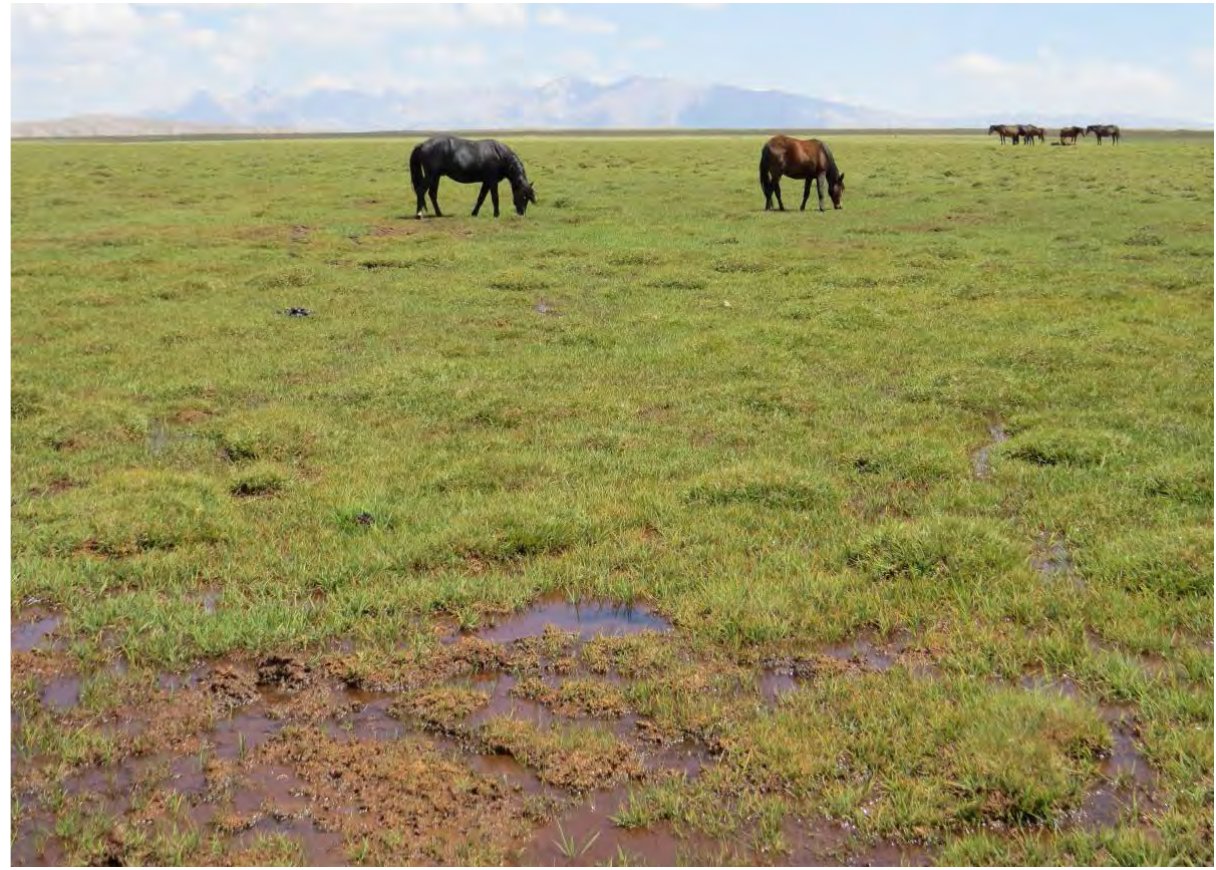
Figure 4. Photograph of the Arpa Peatland (photo Thomas